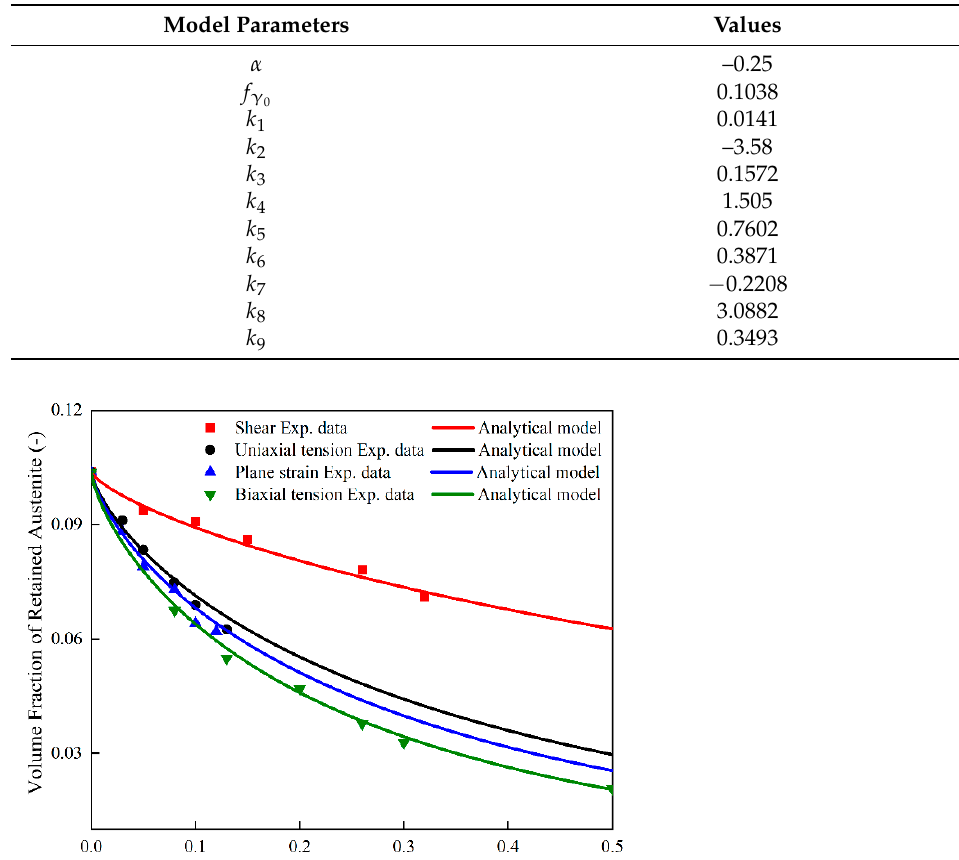
Table 6. Temperature, strain rate and stress state related strain-induced phase transformation model parameters. Model Parameters